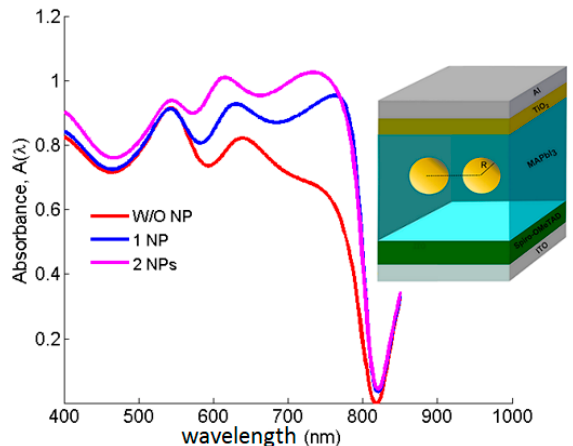
Figure 5. The comparison between the absorption spectra of the perovskite solar cell without the NP and including one and two Au NPs with a radius of 30 nm (inset shows the schematic of the PSC with two embedded Au NPs).